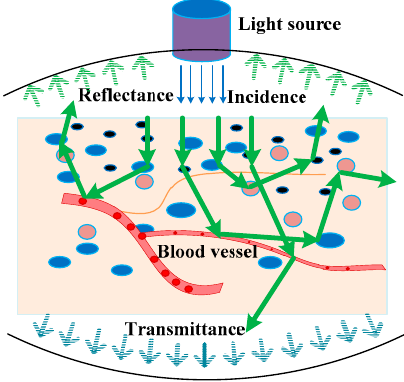
Figure 5. Schematic of light–tissue interaction.